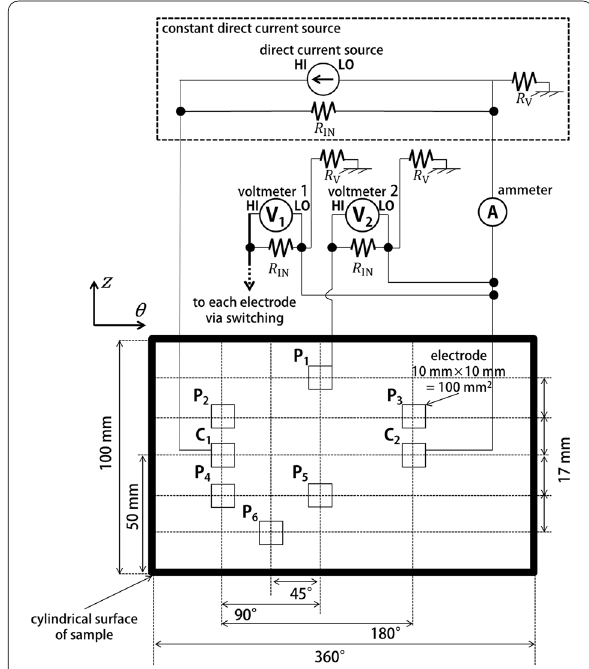
Fig. 11 A scheme of measurement for the cylindrical plastic samples. z and θ are coordinates as defined in Fig. 10. R IN is input resistance, R V is insulation resistance between the negative terminal and chassis ground, HI labels positive terminals, LO labels negative terminals, C 1 and C 2 are current electrodes, and P 1 , P 2 , P 3 , P 4 , P 5 , and P 6 are potential electrodes. The DC source (Model 6243, ADC; Saitama,